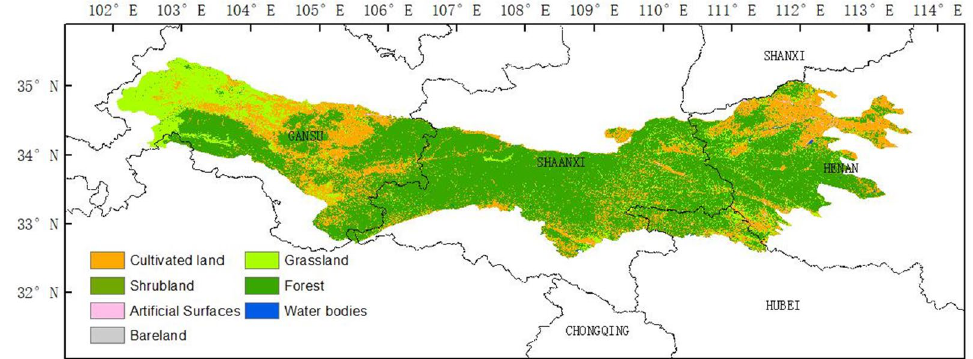
Figure 9. The spatial distributions of Land cover in the Qin Mountains. The distribution of vegetation type in this study is obtained from the Global Land Cover Map with a spatial resolution of approximately 30 m (GlobeLand30) in 2010 (www.globe land3 0.org), which obtained from the GEE. The vegetation types in the Qin Mountains were grouped into cultivated land, forest, grassland, shrub land, water bodies (include wetland), artificial surfaces and bare land. Their area percentage account for 22.53%, 65.85%, 10.12%, 0.12%, 0.38%, 0.99%, 0.005%,